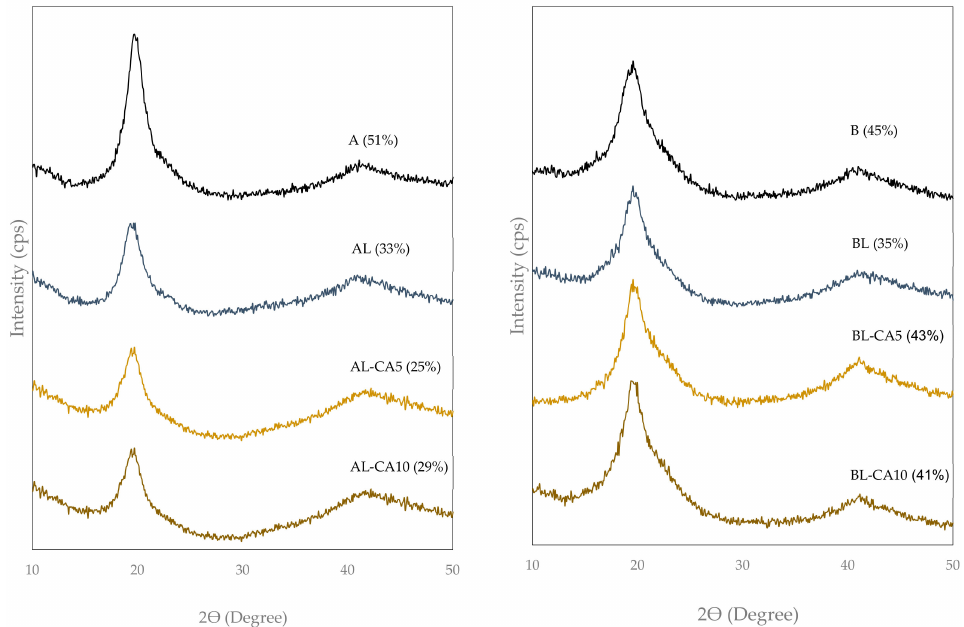
Figure 2. X-Ray di ff raction spectra of the PVA films (A: left and B: right) without and with carvacrol (5 or 10 g / 100 g PVA) previously encapsulated in lecithin liposomes. Percentages of crystallinity are shown for each